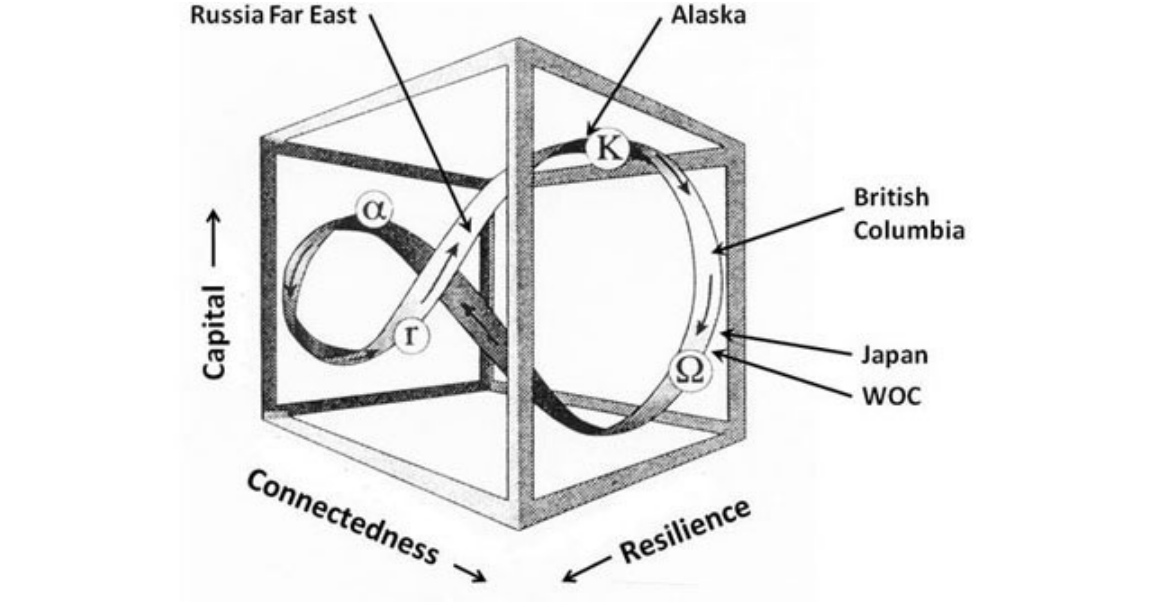
Fig. 3. The stage of the five regional salmon fisheries in the adaptive cycle. Russian Far East fisheries have the highest inferred resilience, followed by Alaska, Japan, British Columbia, and Washington- Oregon-California